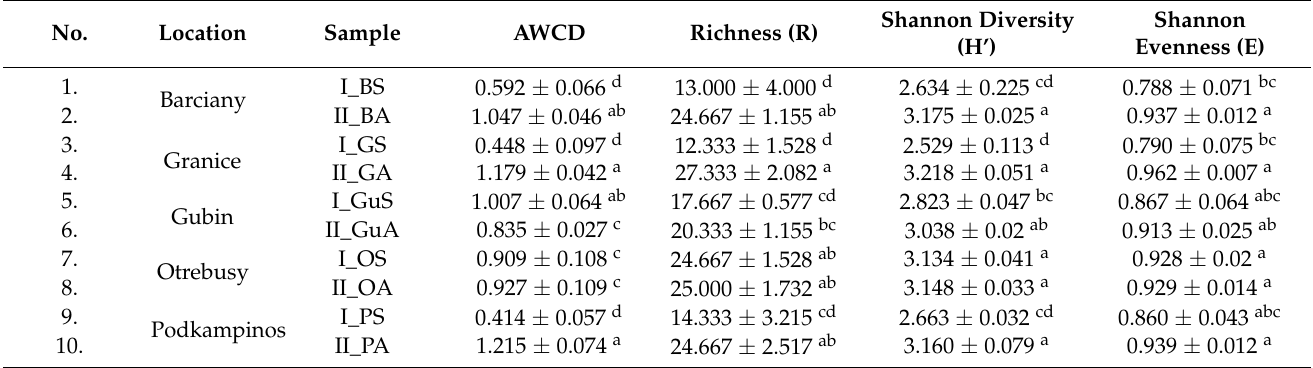
Table 1. Comparison of metabolic functional diversity indices of the microbial communities in leaf samples based on substrate utilisation patterns on Biolog EcoPlates containing 31 different carbon sources. Different letters indicate significant differences ( p < 0.05, n = 3) by Tukey’s HSD